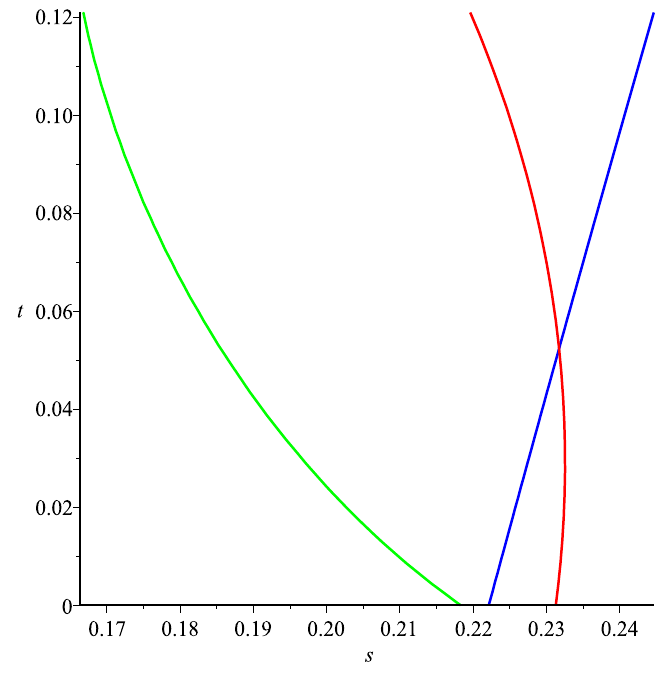
Figure 6. Allocation of a private